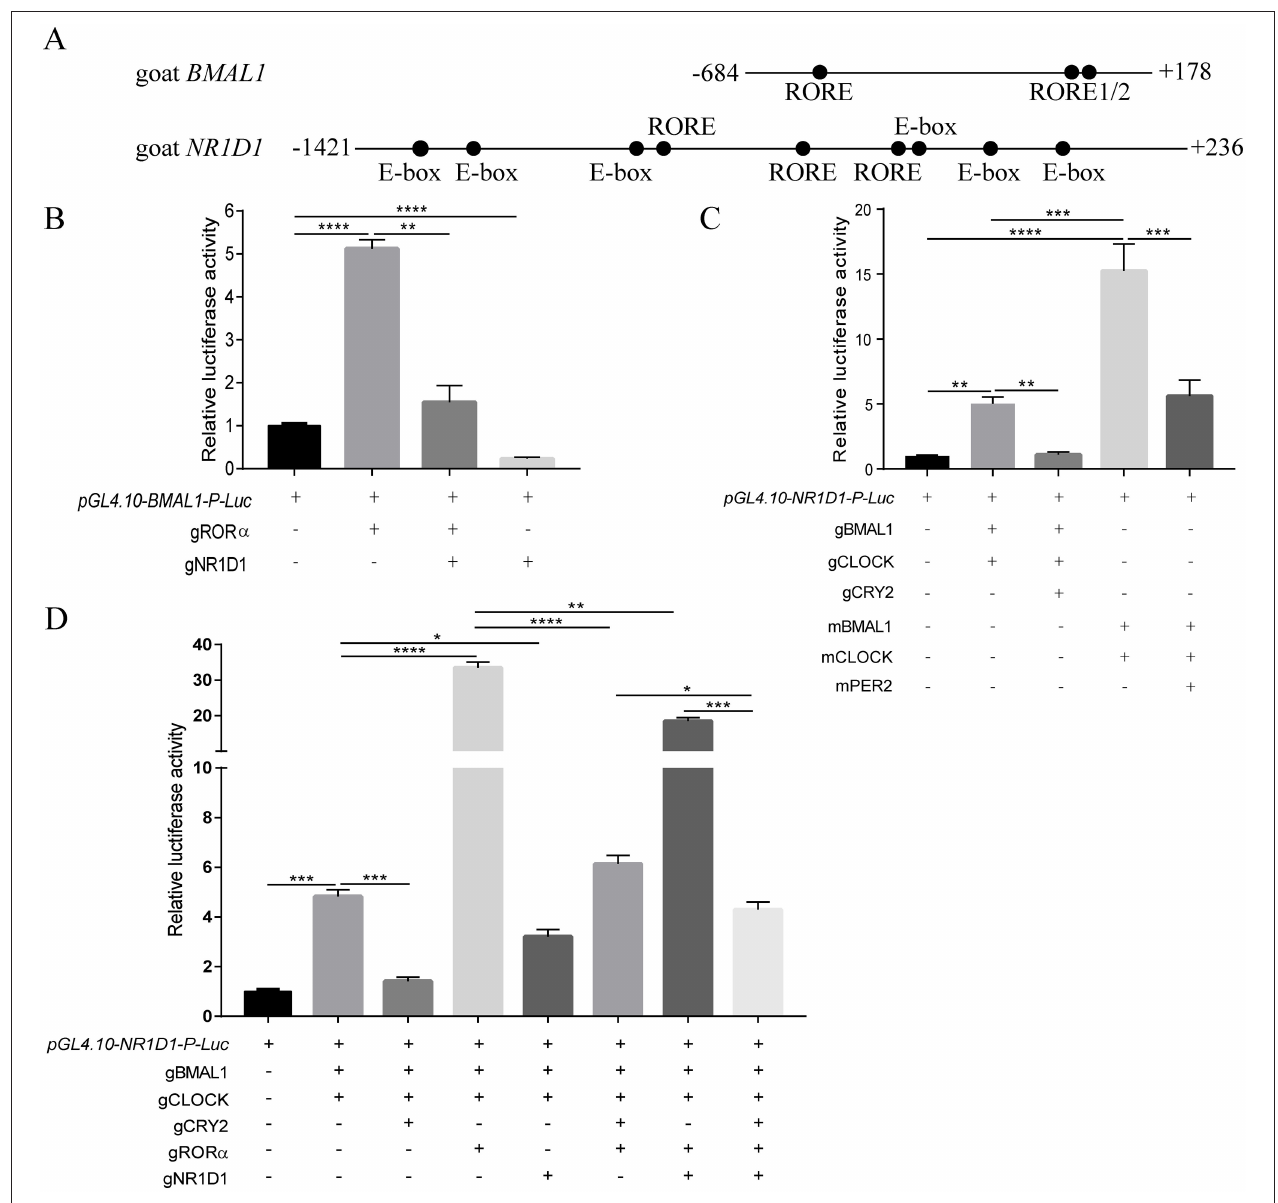
FIGURE 7 | Transcriptional activity of the goat BMAL1 and NR1D1 gene in vitro . Schematics of the BMAL1 and NR1D1 promoter regions in goat (A) . Positions relative to the goat transcriptional start site are indicated. Dots indicate response elements. The roles of transcriptional activators (gROR α , gBMAL1/gCLOCK, mBMAL1/mCLOCK) and repressors (gNR1D1, gCRY2, mPER2) in the caprine circadian clock was investigated by luciferase assays in HEK293T cells. Transcriptional activation of the luciferase reporter containing an 862 bp fragment from the 5 ′ -flanking region of goat BMAL1 (B) . Transcriptional activation of the luciferase reporter containing a 1657 bp fragment from the 5 ′ -flanking region of goat NR1D1 (C,D) . Data are presented as the mean ± SE ( n = 3) of firefly luciferase activity (pGL4.10-gBMAL1-P- Luc or pGL4.10-gNR1D1-P- Luc ) normalized with the Renilla luciferase control (pRL-CMV) from a single assay. The results shown are representative of three independent experiments. The activity in samples transfected with the reporter construct (i.e., pGL4.10-gBMAL1-P- Luc or pGL4.10-gNR1D1-P- Luc without plasmids expressing other proteins) was set to 1.0. P -values were calculated using one-way ANOVA with Tukey’s multiple comparison post-test. Asterisks indicate significant differences. * P < 0.05, ** P < 0.01, *** P < 0.001, **** P <